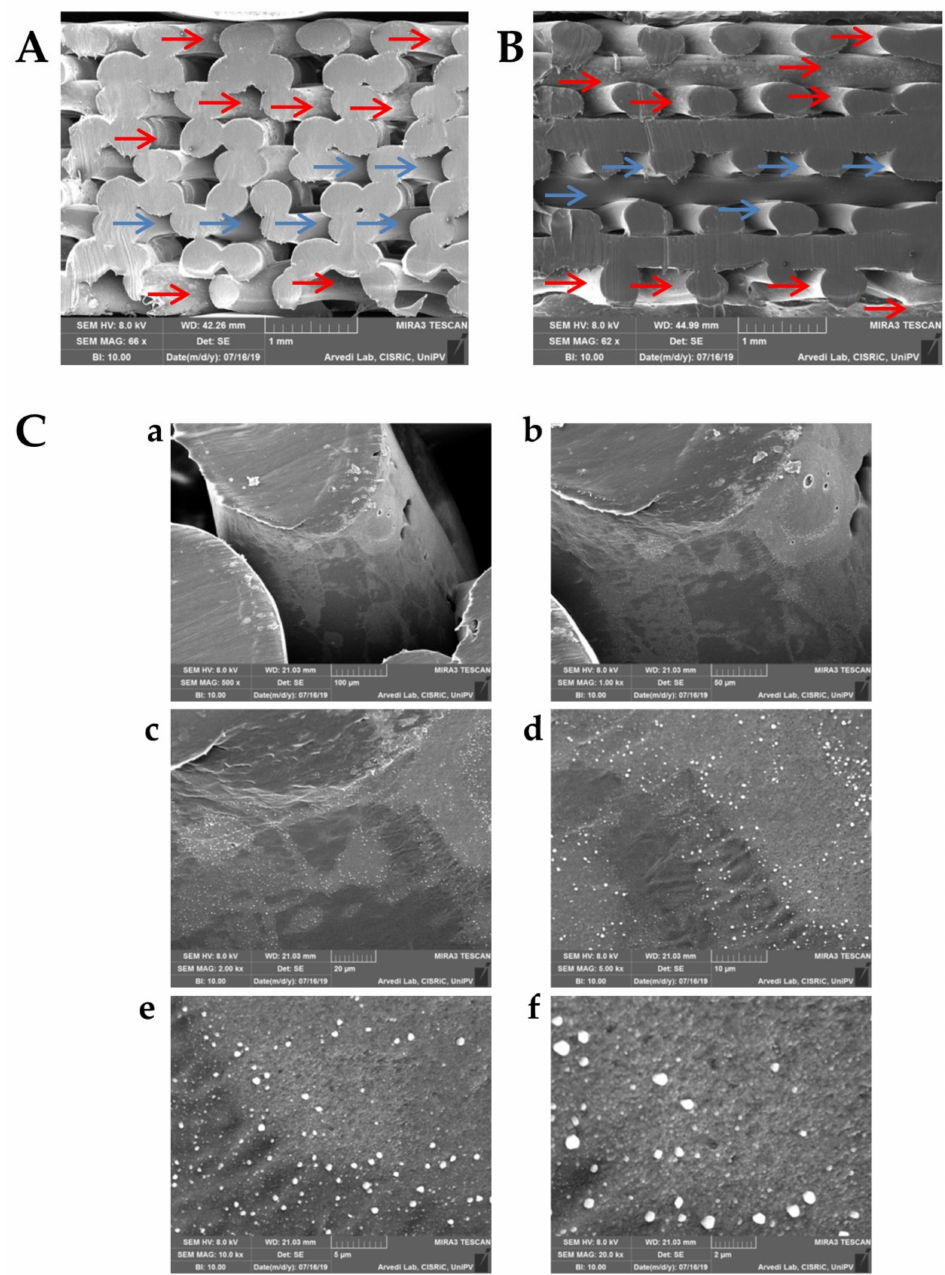
Figure 4. SEM morphological and structural characterizations of 3D-printed PCL scaffolds loaded with lyosecretome, two vertical sections ( A , B ). Presence (red arrows) or absence (blue arrows) of material deposition on PCL fibers is indicated. Increasing magnifications of the material deposited on PCL fibers ( C , magnifications a — f ). Scale bar: 1 mm for ( A ) and ( B ); 100 µ m for ( a ); 50 µ m for ( b ); 20 µ m for ( c ); 10 µ m for ( d ); 5 µ m for ( e ); 2 µ m for ( f